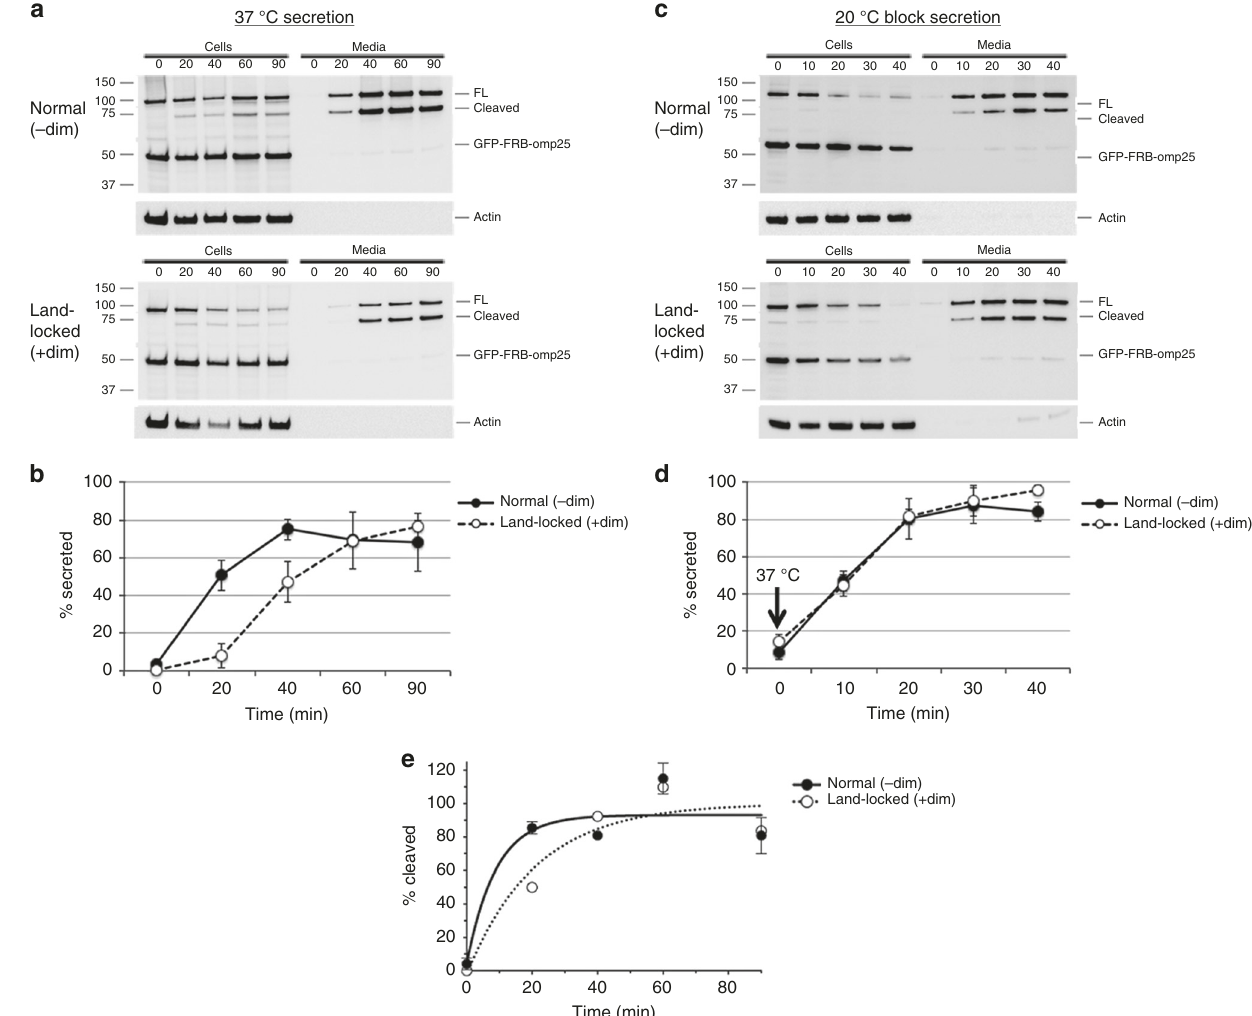
Fig. 5 Bulk secretion through land-locked Golgi. a HT1080 cells that stably express ss-GFP-FM4-FCS-hGH were transfected with GRASP55-FKBP-HA and FRB-GFP-OMP25, then treated with dimerizer for 3 h before initiating secretion by adding solubilizer. Secretion was carried out at 37 °C in the presence of cycloheximide. For each time point, 10% of chase media and cell lysates were loaded for analysis by SDS-PAGE and Western blot with GFP and actin antibodies. Experiments were done in triplicate. b Quanti fi cation of Western blots from a . The % of cargo (full-length and cleaved) secreted was determined by taking the ratio of the secreted cargo (medium) over total cargo (medium + cell). c Secretion after release from 20 °C block. Cells were pre-incubated in dimerizer for 3 h at 37 °C, then cooled to 20 °C for 1 h before adding solubilizer for 2 h, then warmed back to 37 °C to initiate the secretion assay. For each time point, 10% of chase media and cell lysates were loaded for analysis by SDS-PAGE and Western blot with GFP and actin antibodies. Experiments were done in triplicate. d Quanti fi cation of Western blots from c . e Normalized furin cleavage ef fi ciency of ss-GFP-FM4-FCS-hGH for normal and land-locked Golgi was calculated for each time point from cell fractions in a by taking the ratio of cleaved/(full-length + cleaved), and plotting that as a percentage of the maximum secreted amount. The data were fi t to a single exponential curve and normalized to the plateau observed for furin cleavage in land-locked Golgi. Error bars =